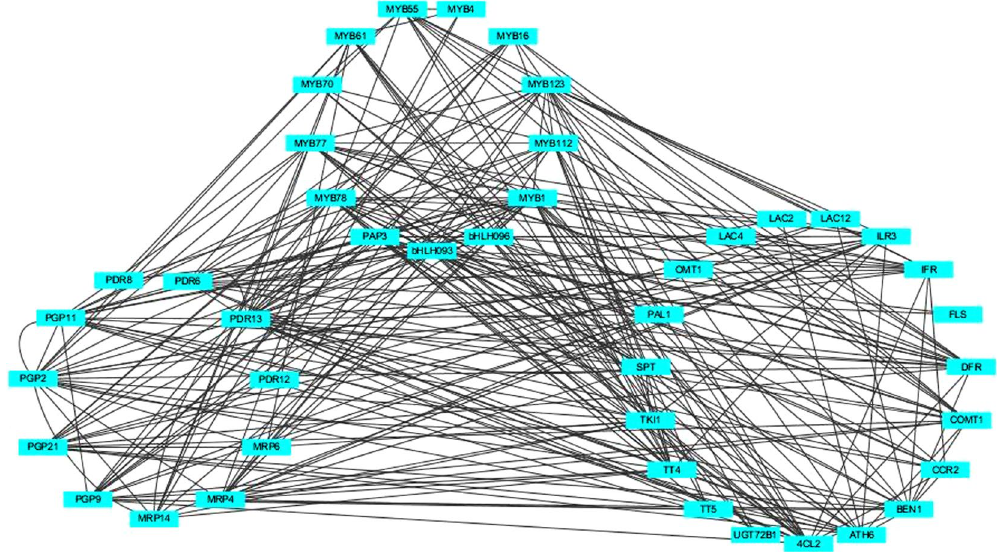
Figure 10. The flavonoid pathway network in MC with a hard cut-off value of |r| = 0.85 using Cytoscape. Nodes indicate individual genes, and edges indicate two genes that are co-expressed, with a cut-off value of |r| = 0.85.